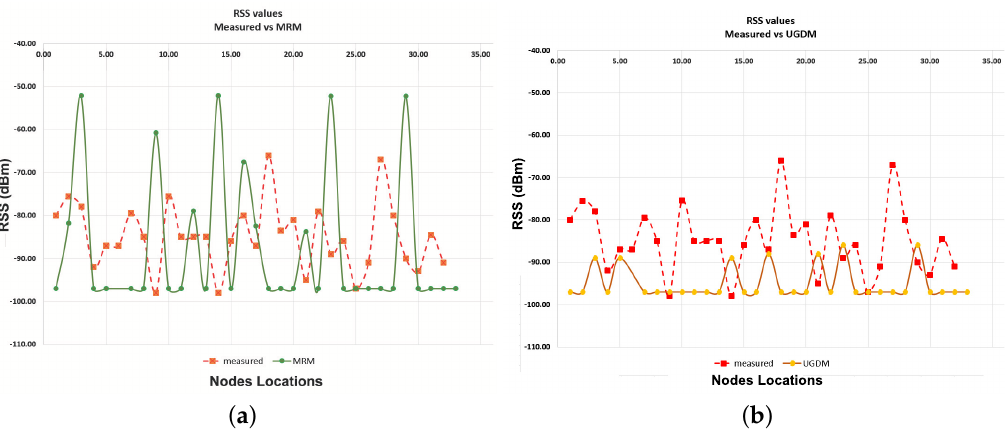
Figure 8. RSS: Measured vs. Cooja built-in Models Simulation ( a ) Measured vs. MRM Simulation; ( b ) Measured vs. UDMG